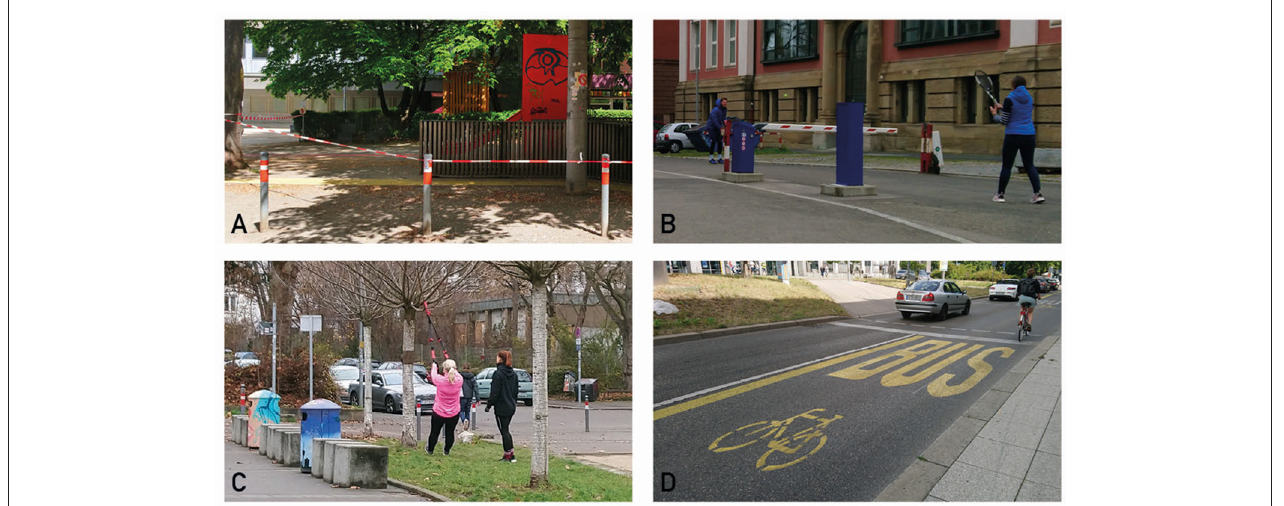
FIGURE 1 | During the initial months of COVID-19 in Europe, access to urban greenery including playgrounds was strictly forbidden in many regions (A) . During times of social distancing, many people creatively used their close surroundings for physical activities and outdoor recreation such as for playing tennis on the street across a parking gate (B) , and using street trees for gymnastics (C) . Other examples are the establishment of pop-up bike lanes in inner city street corridors (D) , interim playgrounds and pocket parks within residential areas, along urban streets. Picture credits: L. Fischer.